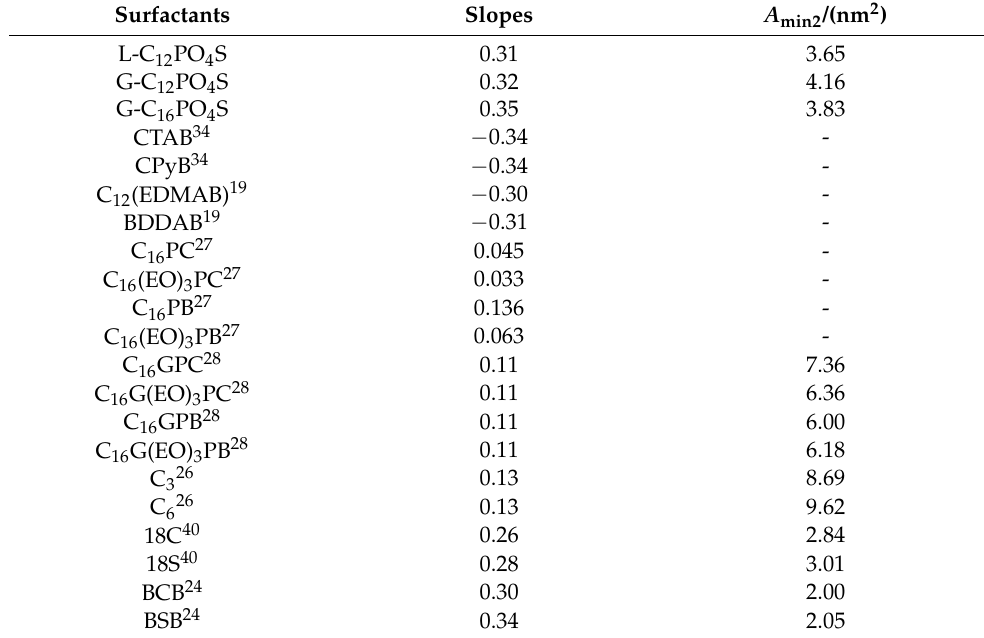
Table 2. The slopes ( Γ SL / Γ LV ) and the theoretical adsorption area ( A min2 ) of the conventional surfactants and several surfactants with specific structures before